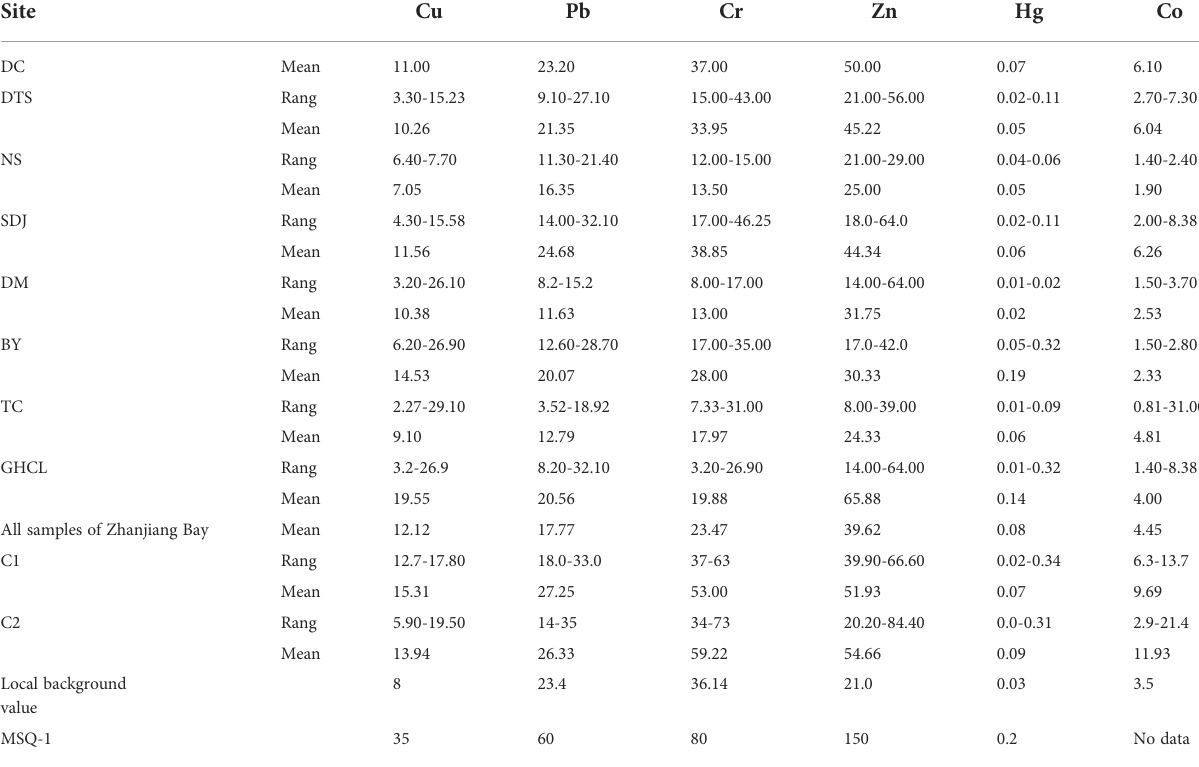
TABLE 2 Heavy metal content ( m g·g -1 ) of surface sediments and cores in Zhanjiang Bay mangroves.